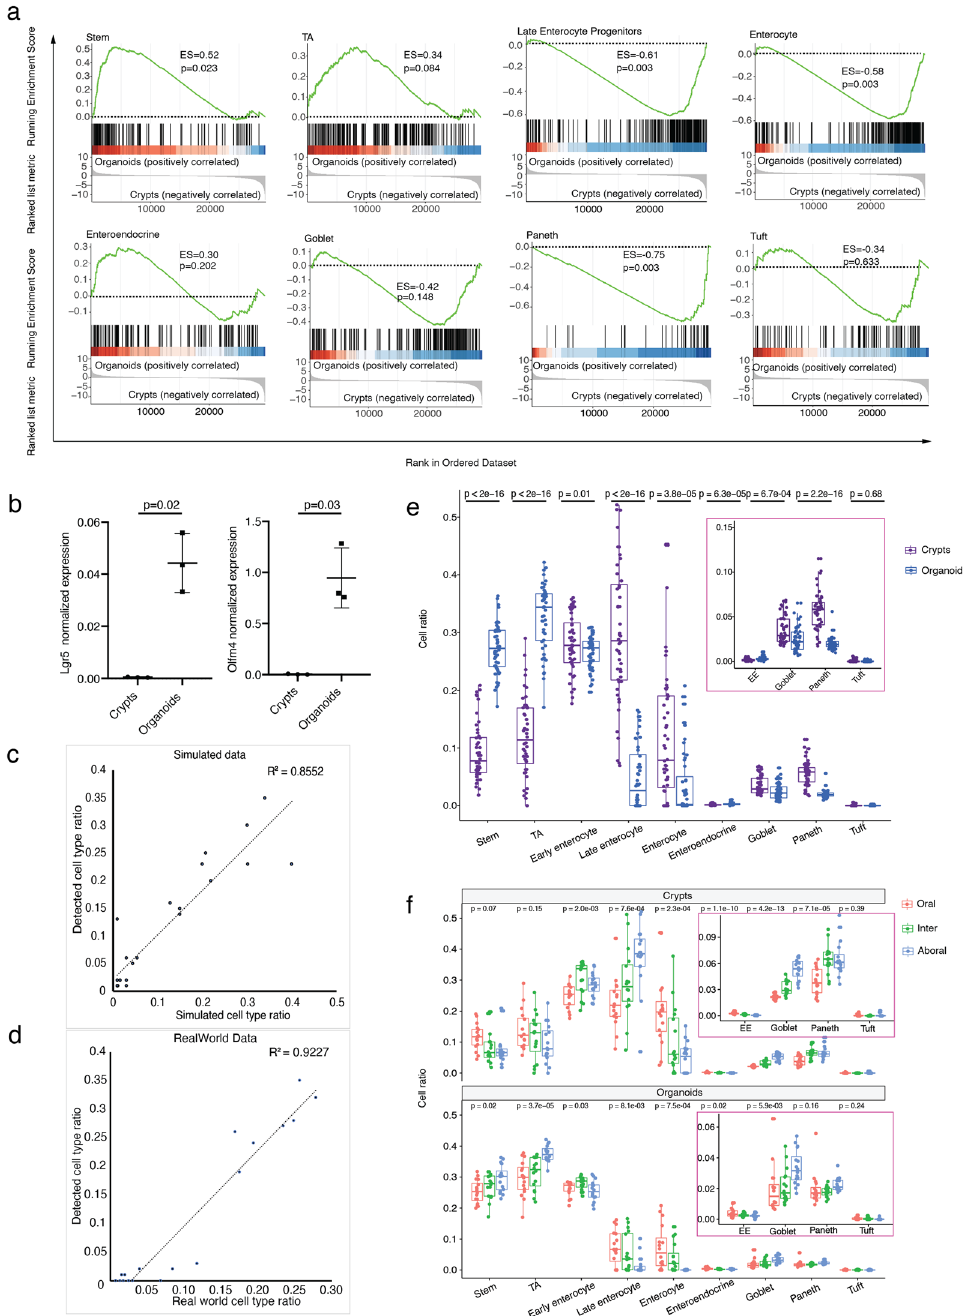
Figure 2. Cell population composition in all the conditions illustrated higher proportion of stem/TA cells in vitro than those in vivo. ( a ) Gene set enrichment analysis (GSEA) between crypts and organoids with intestine epithelial cell-type markers (Stem cell, TA cell, Late enterocyte progenitors, Enterocyte, Enteroendocrine, Goblet, Paneth, Tuft). The enrichment score (ES) reflects the degree to which the genes in a gene set are overrepresented at the top or bottom of the entire ranked list of genes. p-value was calculated using permutation test and was adjusted for multiple comparison by method of “BH” (Benjamini–Hochberg correction). ( b ) Quantitative real-time polymerase chain reaction analysis of relative mRNA expression of stem cell markers (Lgr5 and Olfm4). p-value was calculate using paired two tailed t test. ( c , d ) Scatter plot of validation of cell type deconvolution method (CIBERSORTX) on bulk RNA-seq data in simulated data (B) and real-world data (C). R 2 was performed by Pearson correlation. Feature model was trained by single cell RNAseq (scRNAseq). Simulated data was generated by feature model. Cell type composition in real-world data was defined by single cell RNA-seq. ( e ) Box plot of cell type ratio by group of crypts and organoids (EE: Enteroendocrine). p-value was calculated by Welch’s two-tail t-test. ( f ) Box plot of cell type ratio by group of compartment (EE: Enteroendocrine). p-value was calculated by one-way anova